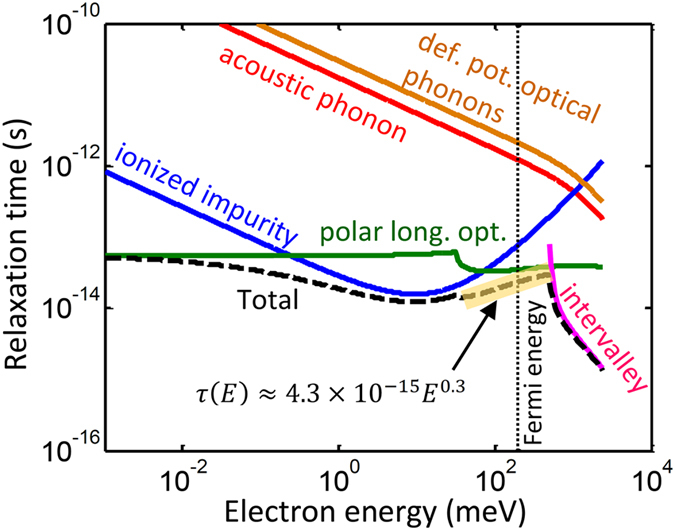
Relaxation times versus energy for different electron scattering mechanisms in Al0.12Ga0.88As for doping concentration of 1.44 × 1019 cm−3 at 1000 °C.